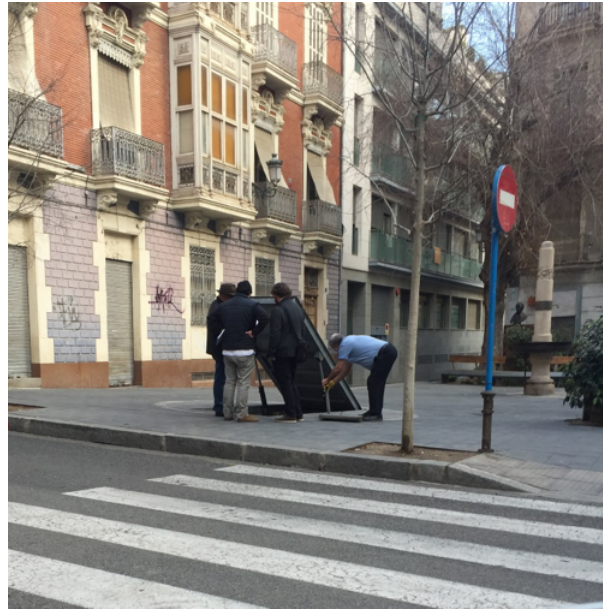
Figure 9. Image showing the opening of the hydraulic access to the Plaza Balmis refuge on Canalejas Street. This entry is being modified by a fixed type for greater